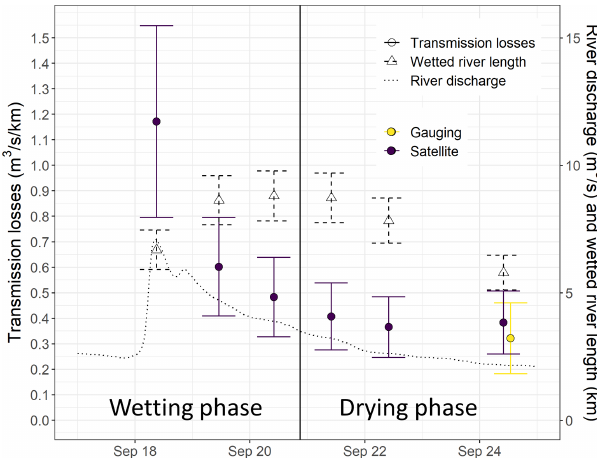
Figure 6. Time series of the river discharge (black dotted line), wet- ted river length (black dashed error bars and triangles) and transmis- sion losses (solid error bars and circles) estimated using differential gauging (“Gauging”, yellow) and river drying front locations iden- tified on satellite imagery (“Satellite”, purple) during the Septem- ber 2020 selected